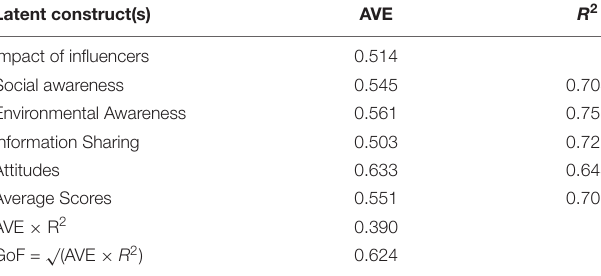
TABLE 8 | Calculation of Goodness of Fit (GoF)